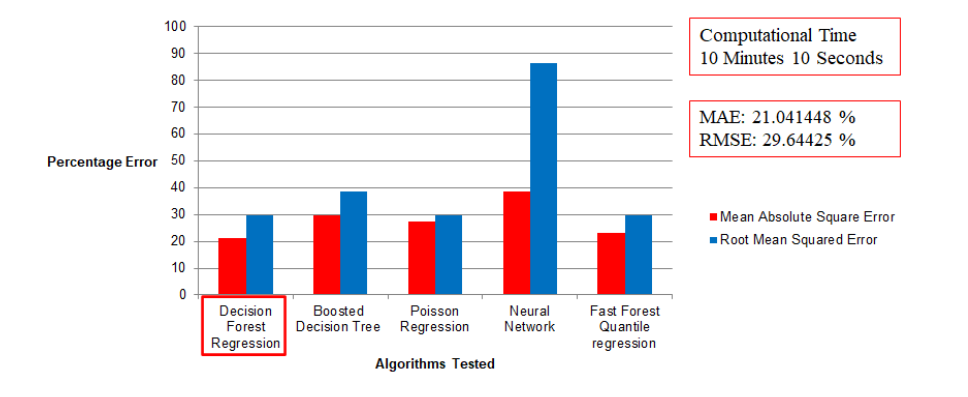
Figure 7. Regression model results for double case.